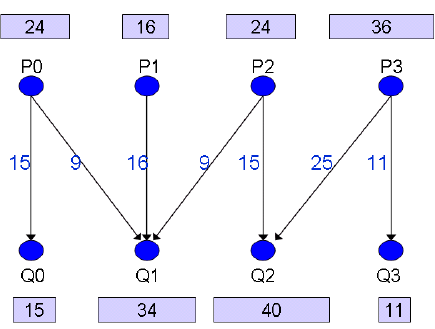
Figure 3. An example for GB ( 4, 4 ).